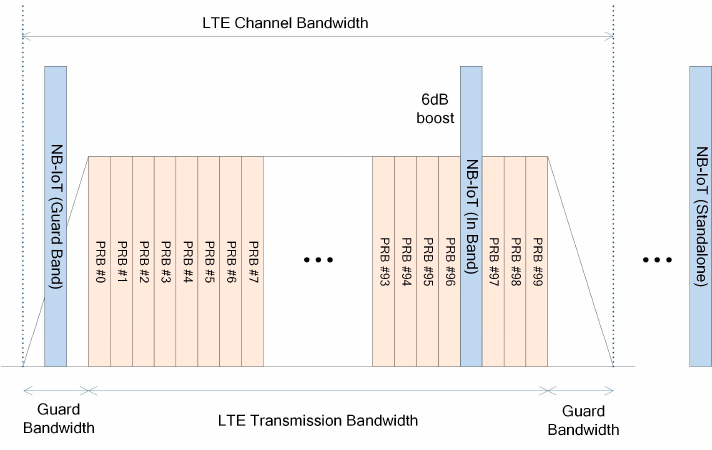
Figure 3. NB-IoT deployment scenarios.